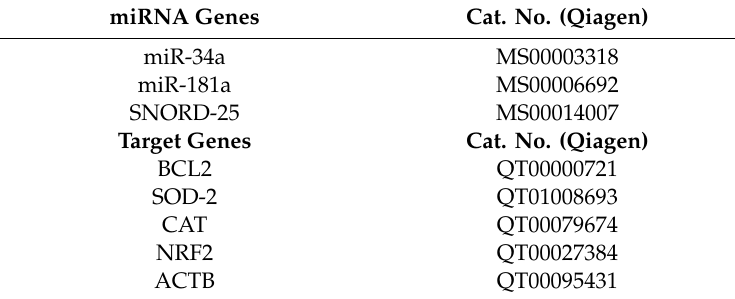
Table 1. Primers used for real time